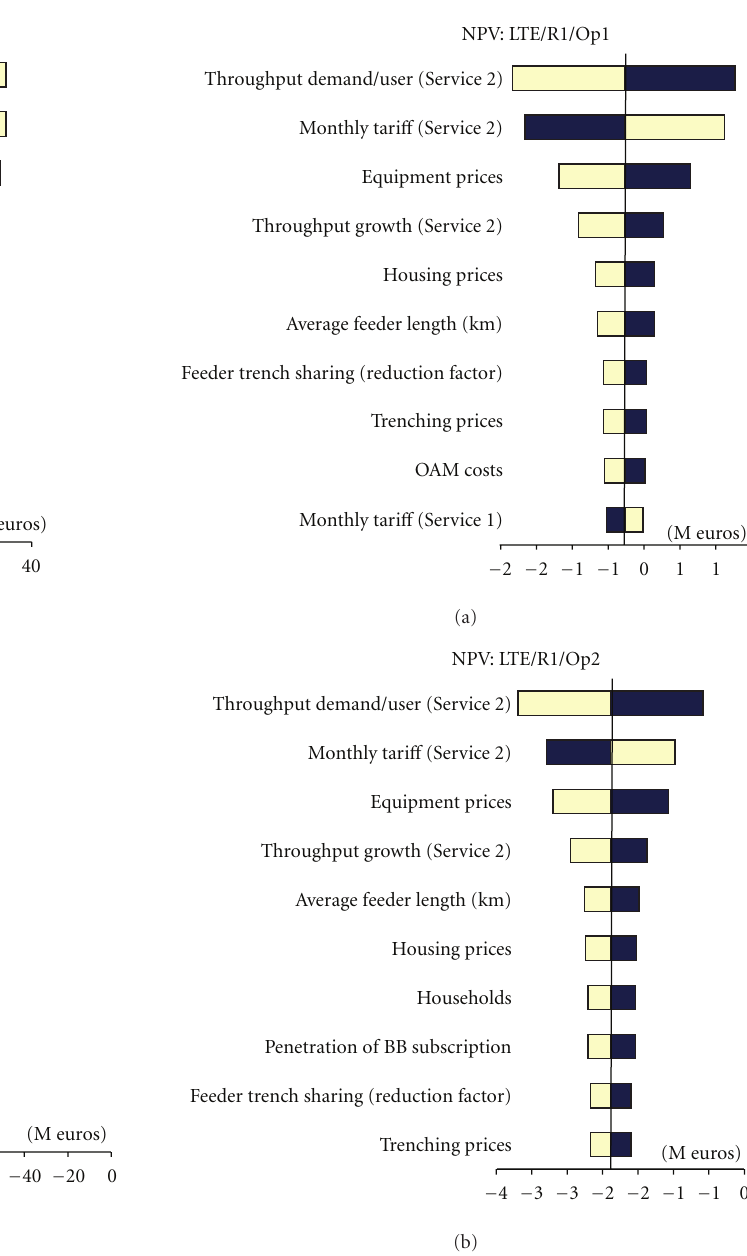
Figure 5: Sensitivity analysis results, FTTH(PON)/urban area/Op. 1 and 2. Figure 6: Sensitivity analysis results, LTE/rural area/Op. 1 and